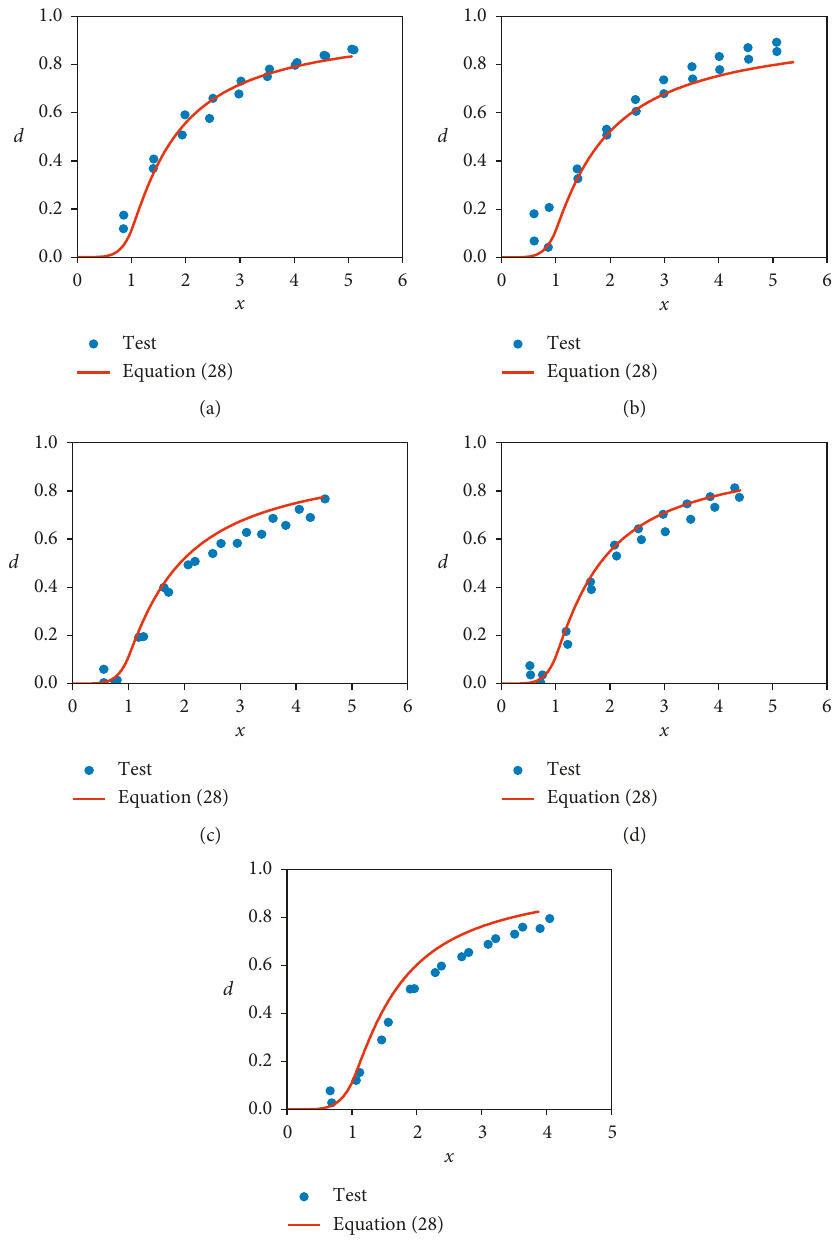
Figure 14: Damage evolution of the RAC in this study. (a) NAC ( r � 0). (b) RAC-25 ( r � 25%). (c) RAC-50 ( r � 50%). (d) RAC-75 ( r � 75%). (e) RAC-100 ( r �